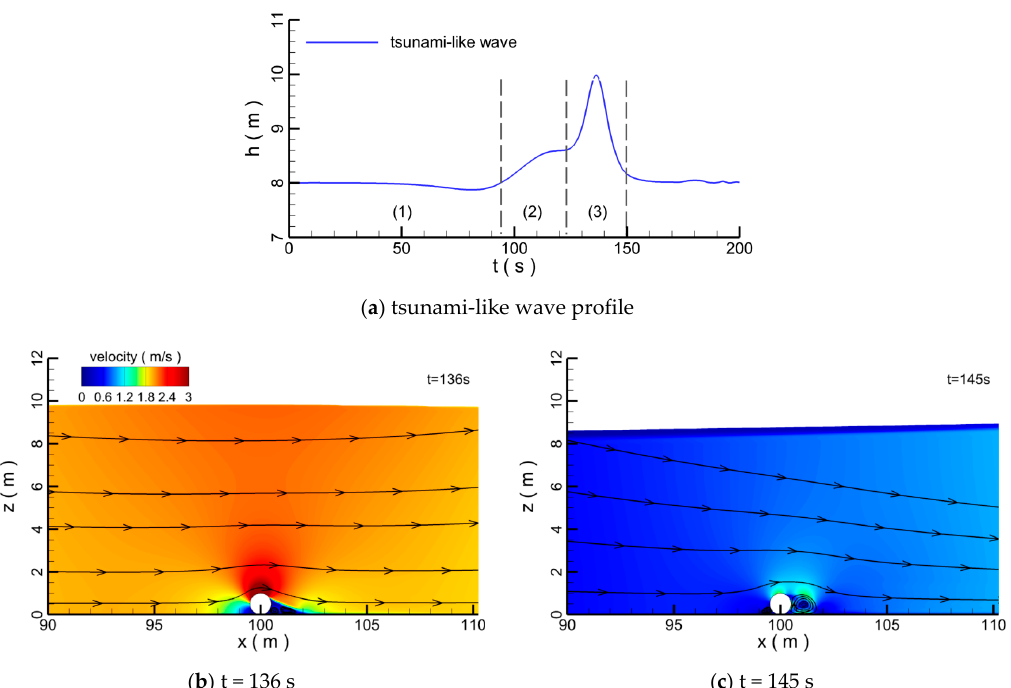
Figure 12. Snapshots of the velocity contour around the submarine pipeline at different times for the tsunami-like wave.